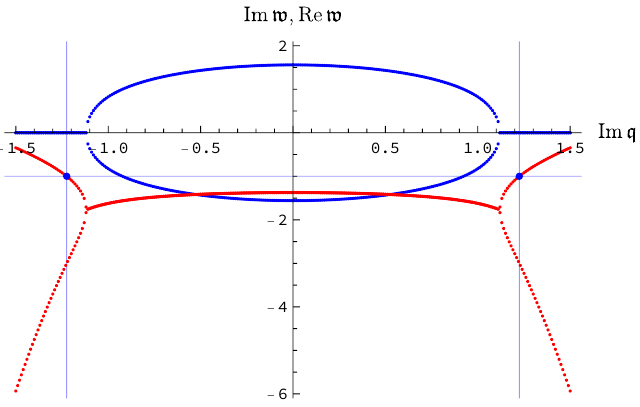
Figure 3 . The (cid:12)rst two (closest to the origin) poles of the retarded function of T xy in the strongly coupled N = 4 SYM theory, obtained using the dual holographic description. The locations of the poles are plotted as functions of the dimensionless wave vector for q purely imaginary, with Re w shown in blue, and Im w shown in red. The dots indicate the points ( q (cid:3) ; w (cid:3) ) = ( (cid:6) i where the response function of T xy exhibits